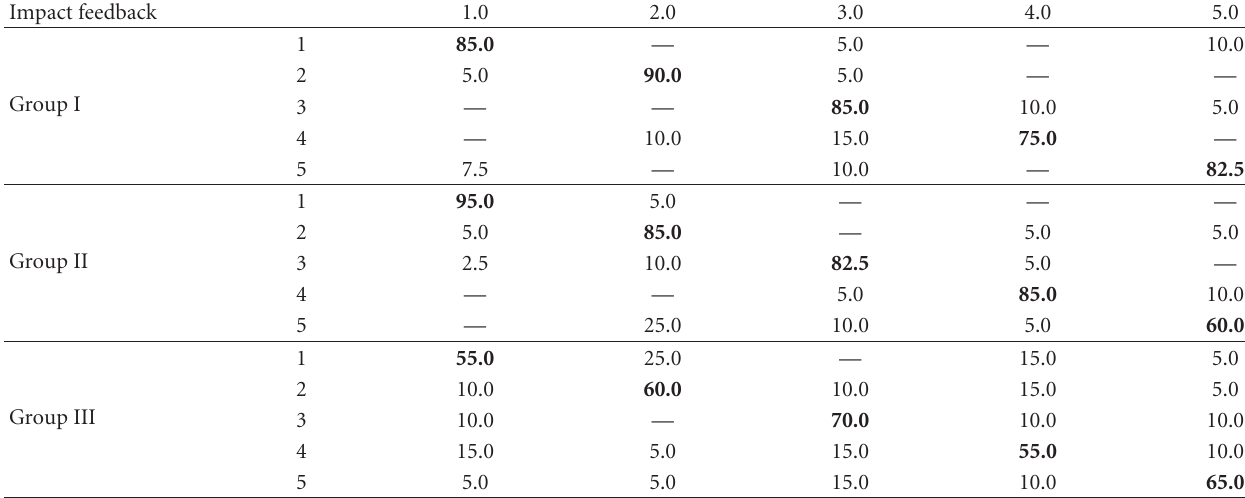
Table 6: Experimental results for impact feedback (%).